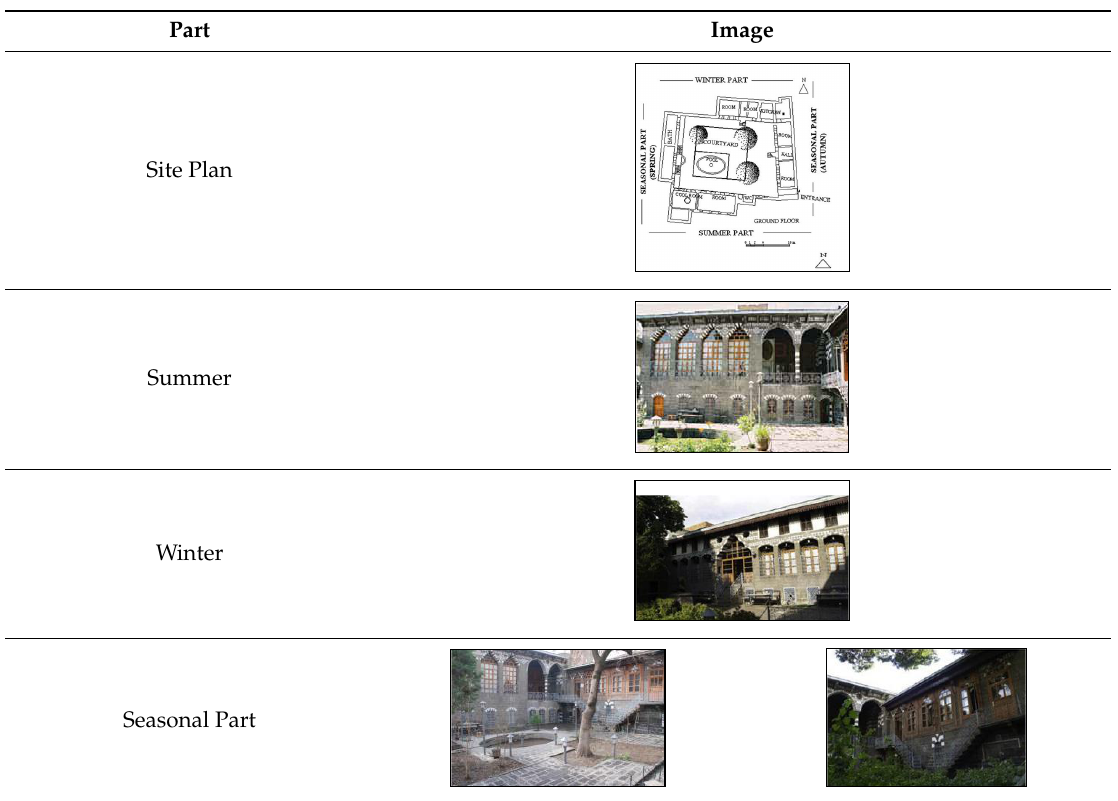
Table 2. Parts of a typical traditional house in the Diyarbakır old town settlement, Cahit Sıtkı Tarancı house [33].